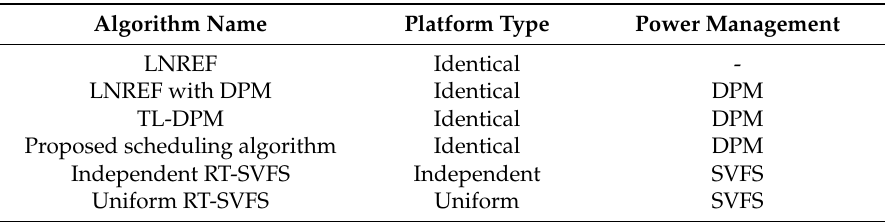
Table 3. Summary of T-L plane based scheduling